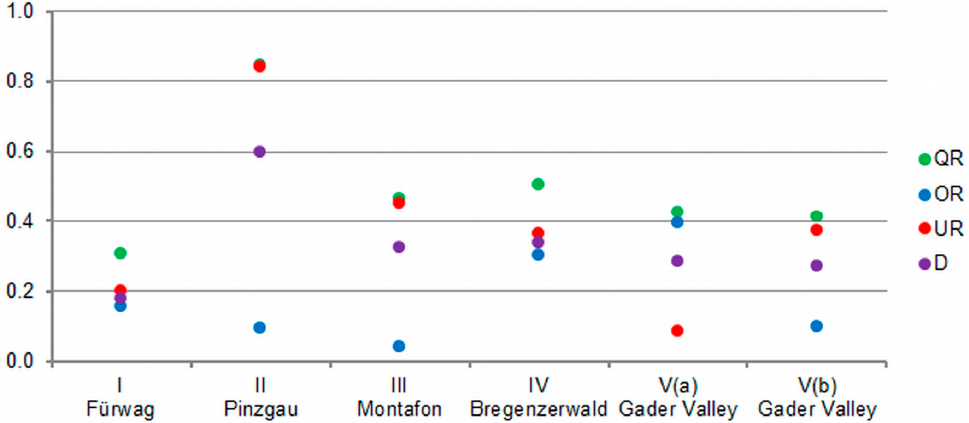
Figure 8. Global spatial accuracies for the selected study sites. Results presented for four metrics; Quality Rate (QR), Under-Segmentation Rate (UR), Over-Segmentation Rate (OR), and the UR-OR compound metric D.